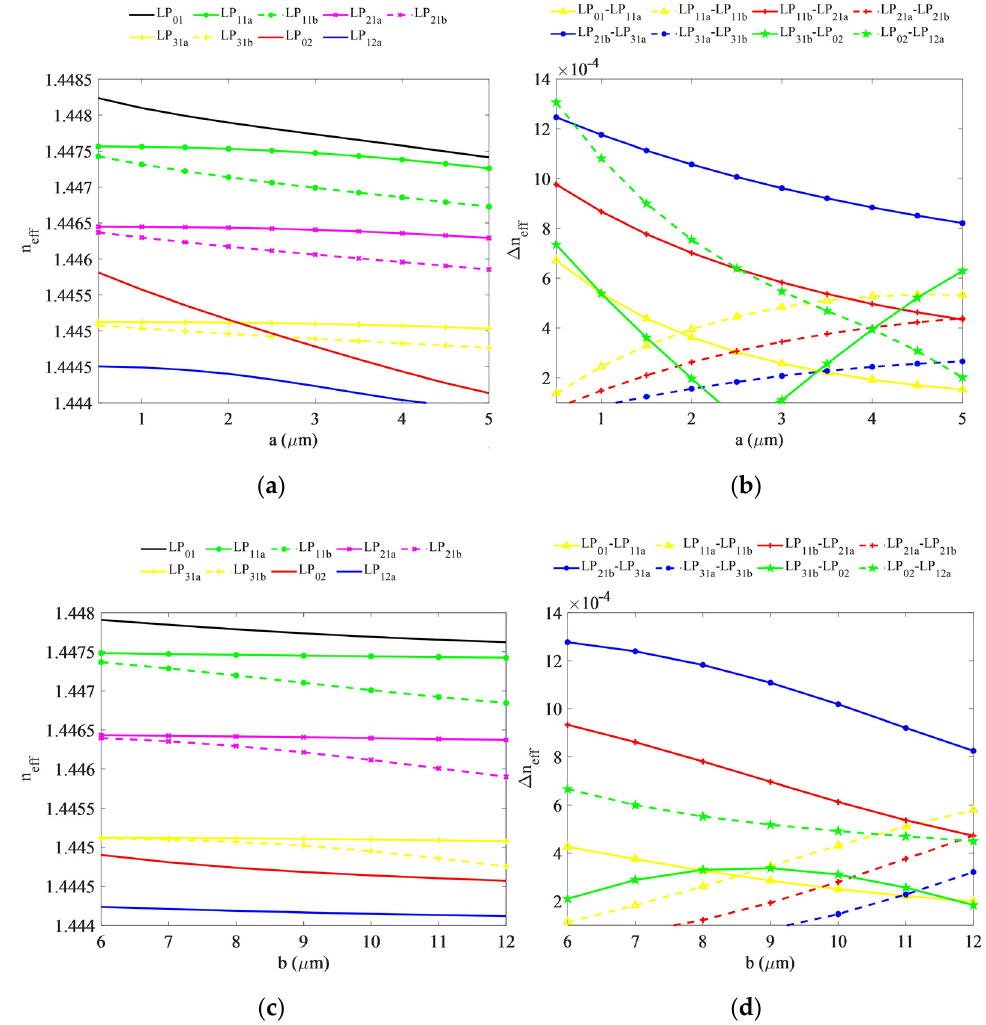
Figure 4. The effect of a on ( a ) the effective refractive index (n eff ) of each mode and ( b ) the effective refractive index difference ( Δ n eff ) between adjacent modes; the effect of b on ( c ) the n eff of each mode and ( d ) the Δ n eff between adjacent modes.